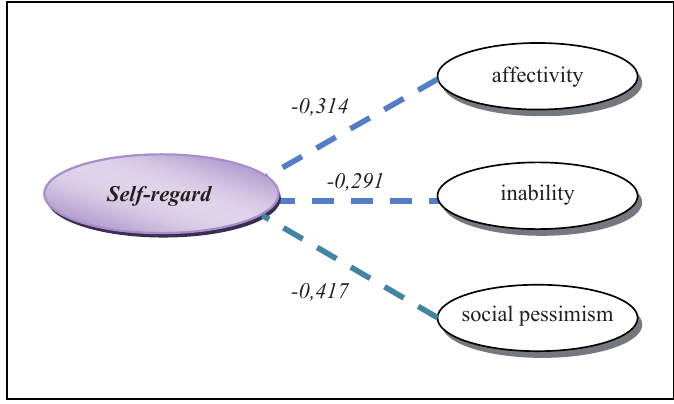
Fig. 7. Correlation of self-regard with suicidal